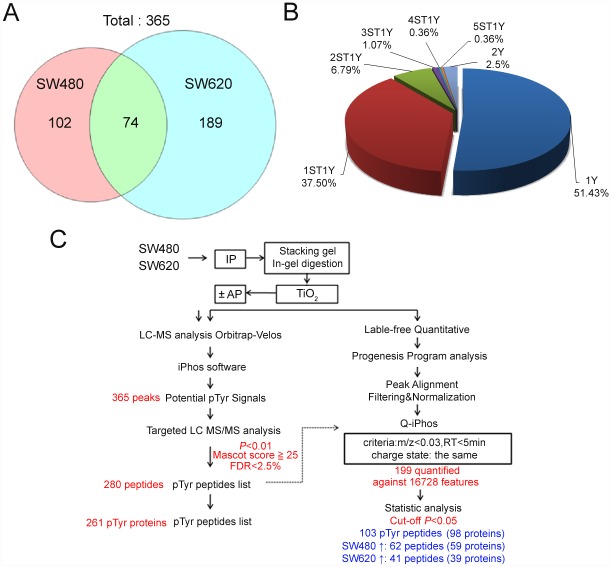
The identified phosphopeptide signals from LC-MS and LC-MS/MS analyses.(A) A total of 365 m/z signals that were identified as potential phosphopeptides from SW480 and SW620 cells were filtered using the iPhos program. There were 74 peptides that overlapped and presented in both cells. There were 102 and 189 potential phosphopeptides with differential level in the SW480 and SW620 cells, respectively. (B) A summary of single (n = 144, 51.4%), double (n = 105, 37.5%) and multiple (n = 31, 11.1%) phosphorylation sites from the identified phosphorylated peptides identified by the Mascot search. (C) A summary of the overall results through a flowchart of the label-free quantitative analysis.